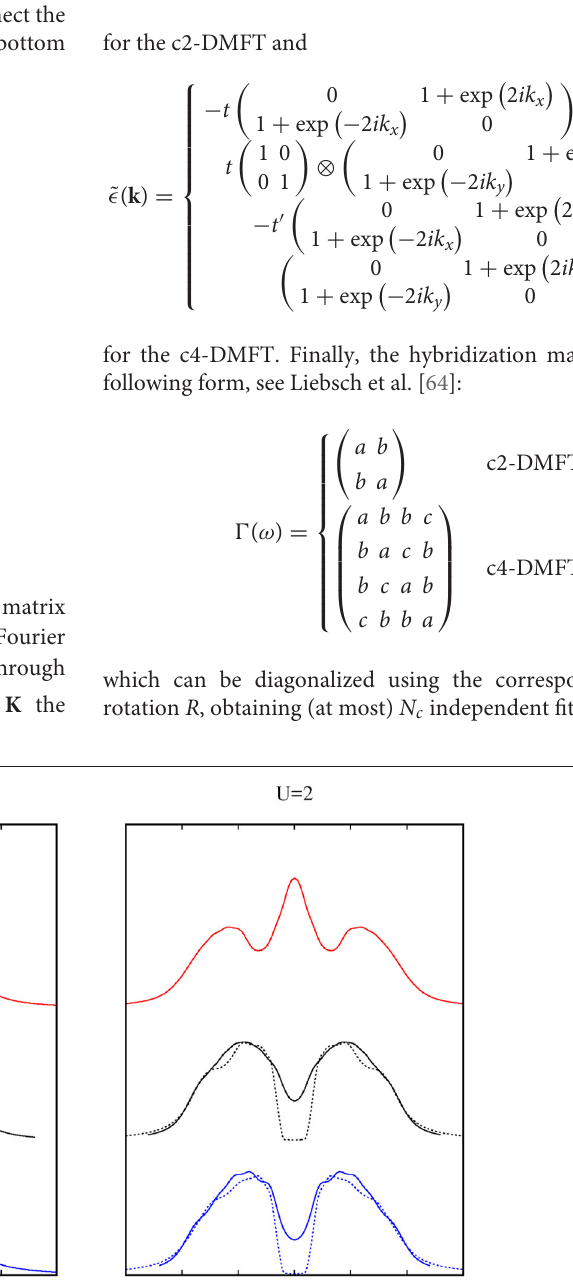
Frontiers in Physics | www.frontiersin.org